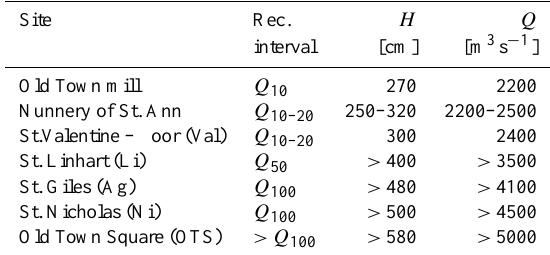
Table 2. Selected important sites (water level indicators) with rela- tions between water levels and peak